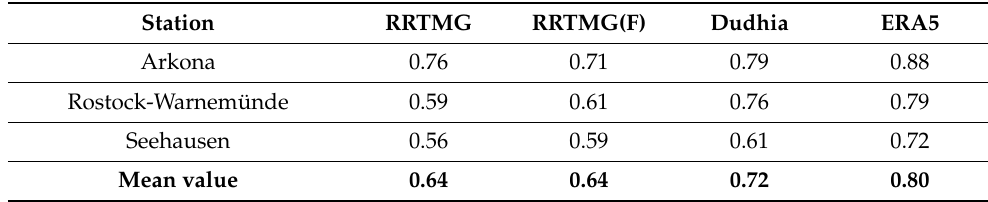
Table 12. Pearson’s correlation coefficients for individual stations.